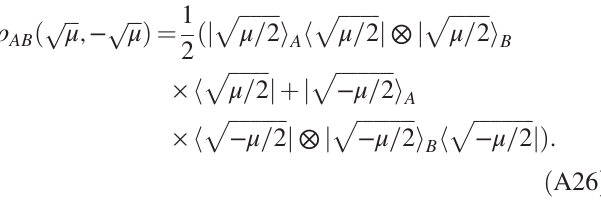
FIG. 5. (a) A specific realization of Protocol I, where Charlie prepares j diagram of Protocol II, where Alice and Bob prepare j